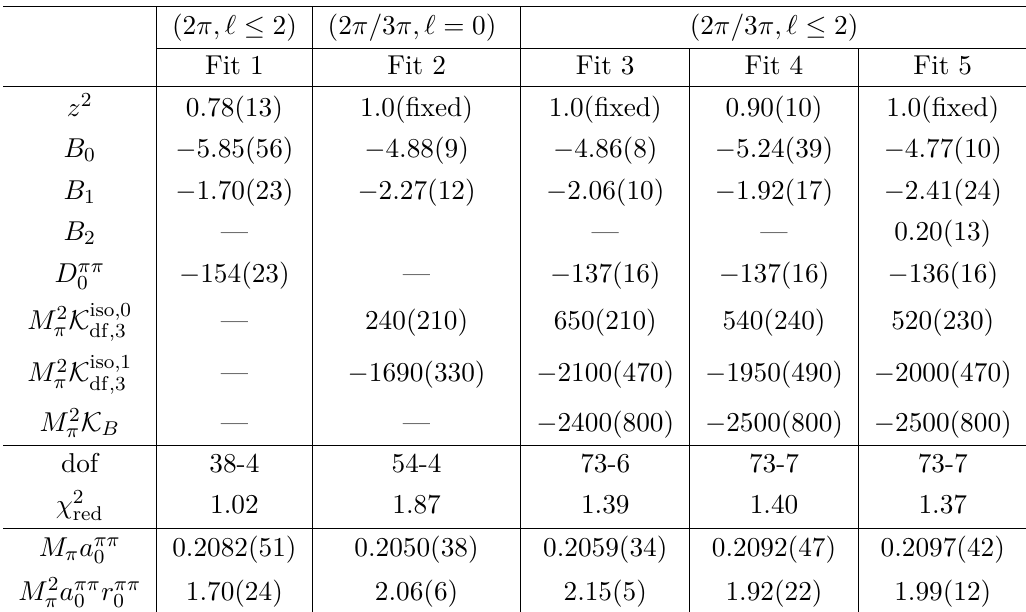
Table 4. Fit results for pions on the N203 ensemble with M π L = 5 . 405365 , using the Adler-zero form for the s -wave phase shift. Each fit contains all 2 π + and 3 π + energy levels (in the